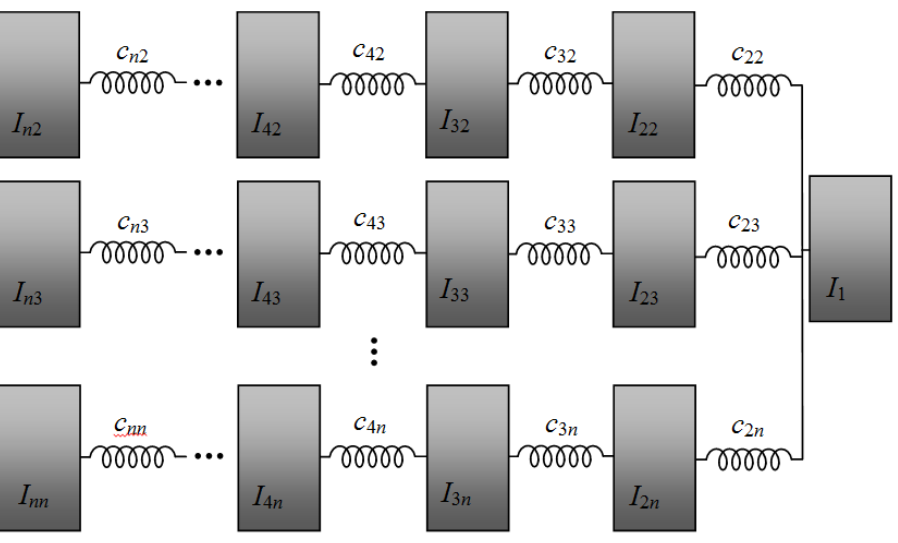
Figure 2. Cascade—branched of the free drive system.